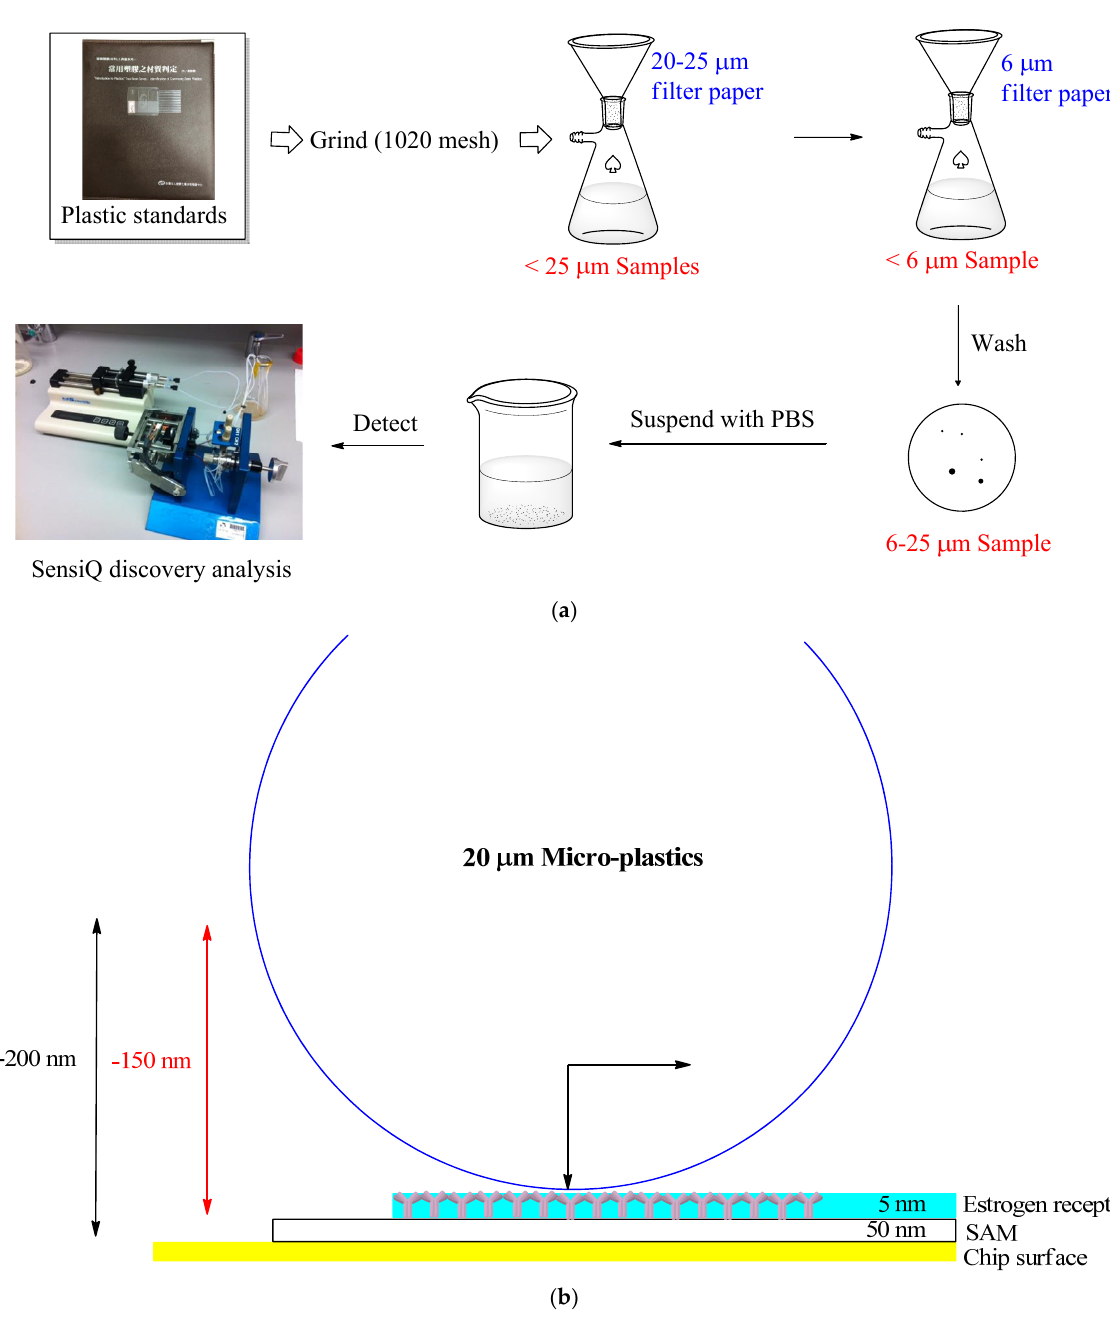
Figure 1. Schematic presentation of the experimental procedure. ( a ) General procedure of detection of micro-plastics based on SPR biosensor. ( b ) Schematic presentation of micro-plastic detection using ERs immobilized on COOH5 SPR sensor. Here, 200 nm (double arrow) refers to the detectable range of SPR; 150 nm (double arrow) refers to the detectable range of micro-plastics after subtracting the SAM and estrogen receptors immobilized on the chip; the arrow inside the particle indicates the driving force of gravity and the flow rate of the micro-plastics in the